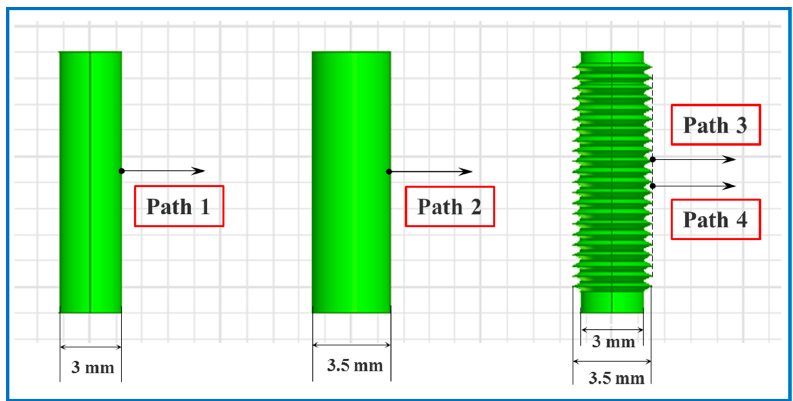
Figure 8. Path locations of different matrix rods.